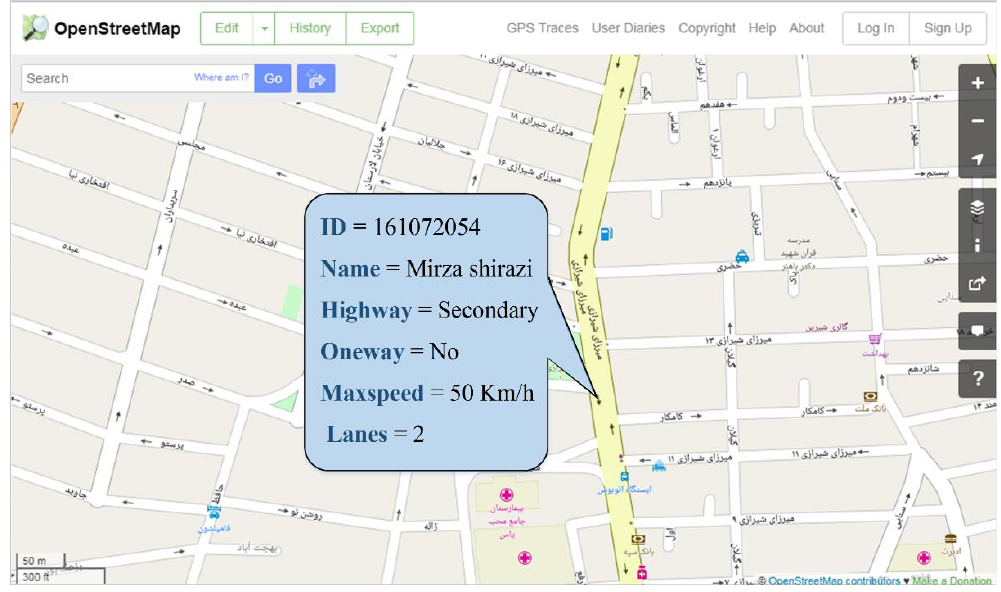
Figure 9. An example of tags of Mirza Shirazi Street in OSM.